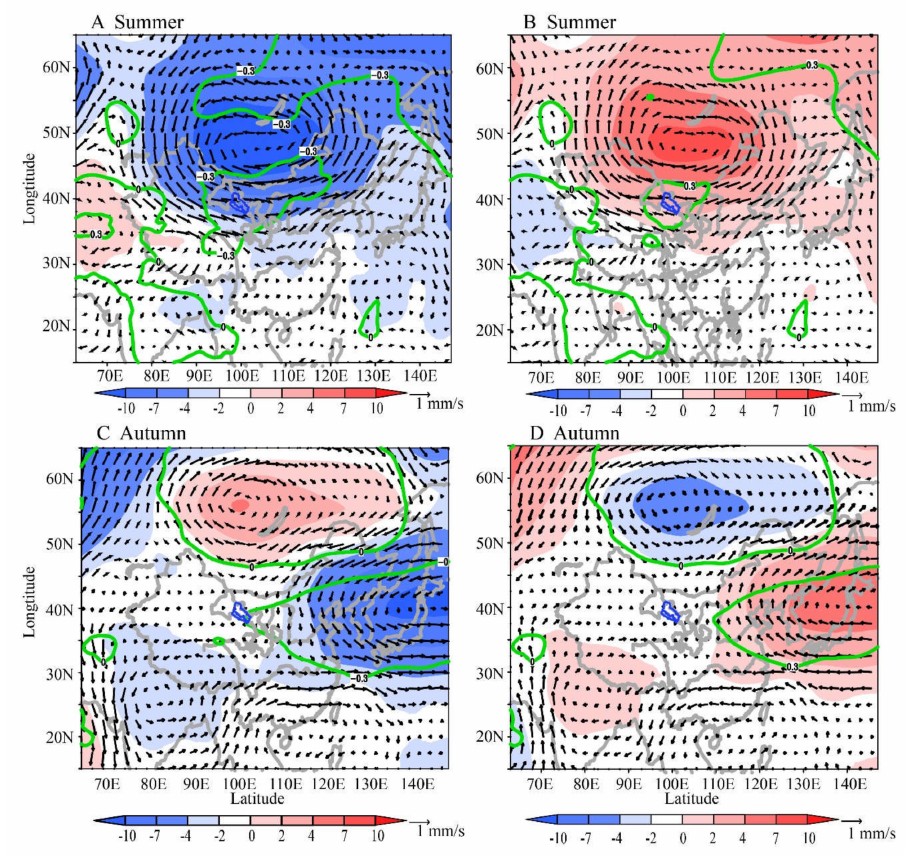
Figure 8. Anomaly of wind (arrows; unit: m/s), temperature (green contour line; unit: ◦ C), and geopotential height (shading; unit: GPM) at a pressure level of 500 hPa in 1984–1997 ( left ) and 1998–2014 ( right ) for summer ( top ) and autumn ( bottom ), referring to the mean of